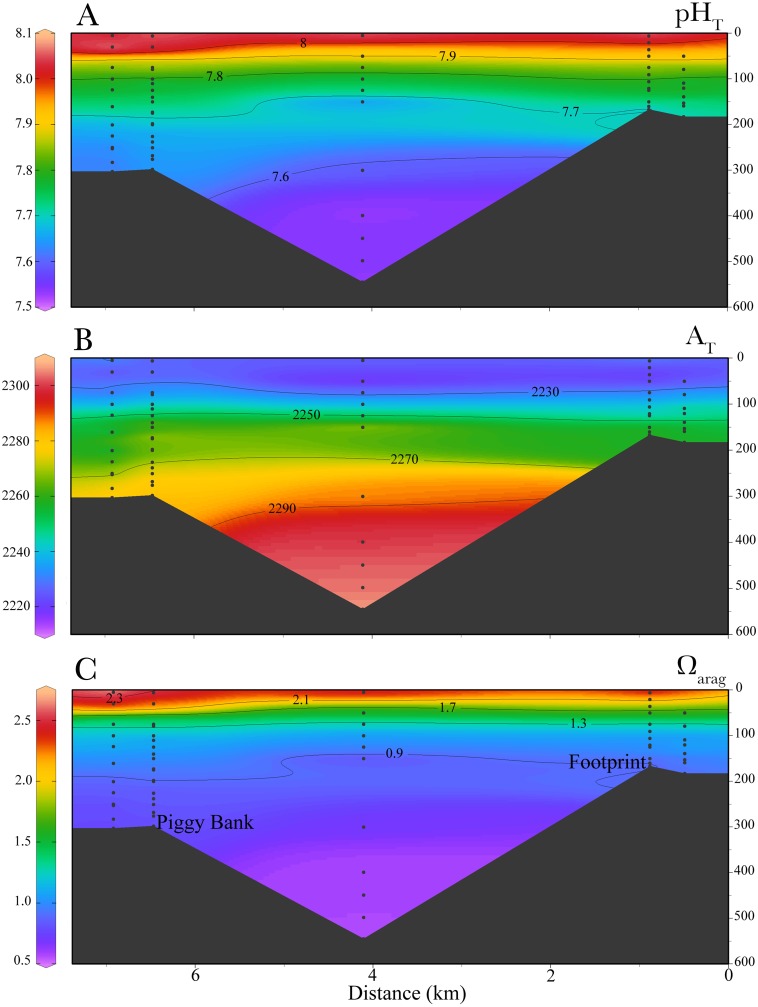
Cross-sectional profiles of in-situ carbonate chemistry parameters.Profiles are for (A) total pH (pHT), (B) total alkalinity (AT) (C) and aragonite saturation (Ωarag) in the South California Bight where L. pertusa were collected.